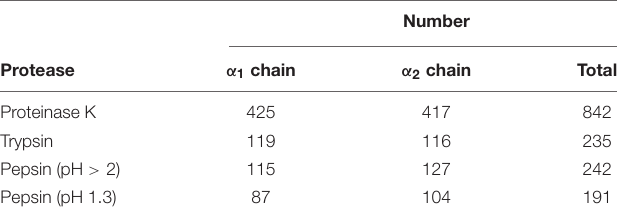
TABLE 1 | The cutting sites number of